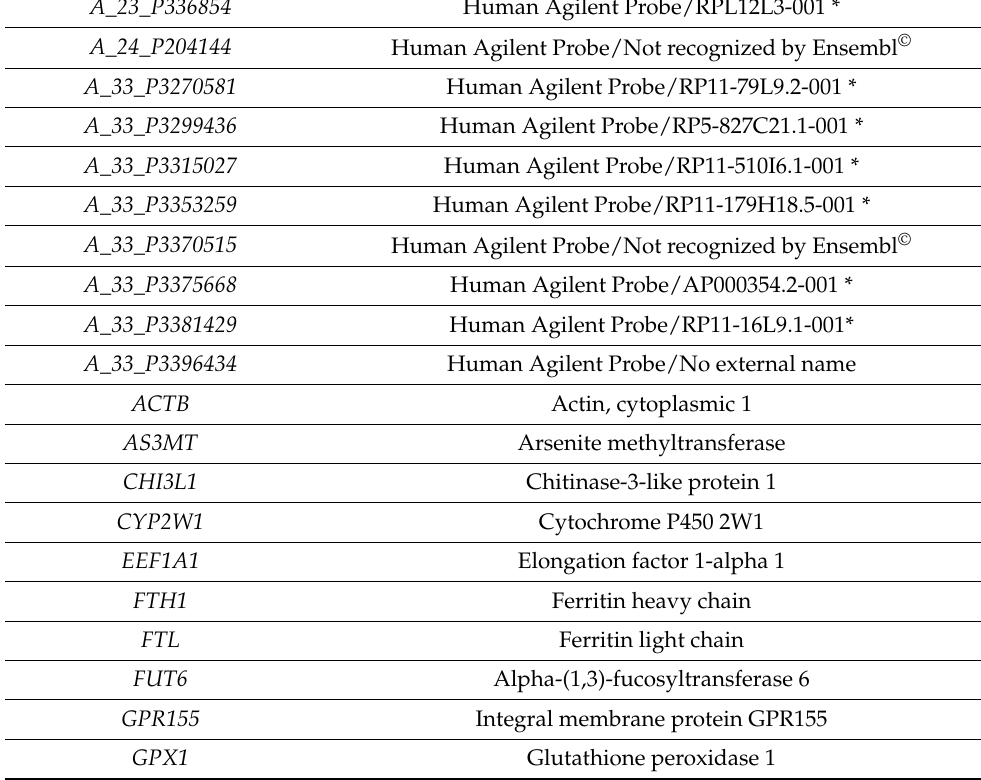
Table 1. Common genes expressed in CTRL and KNbO 3 salt exposed THP-1 cells. *: match